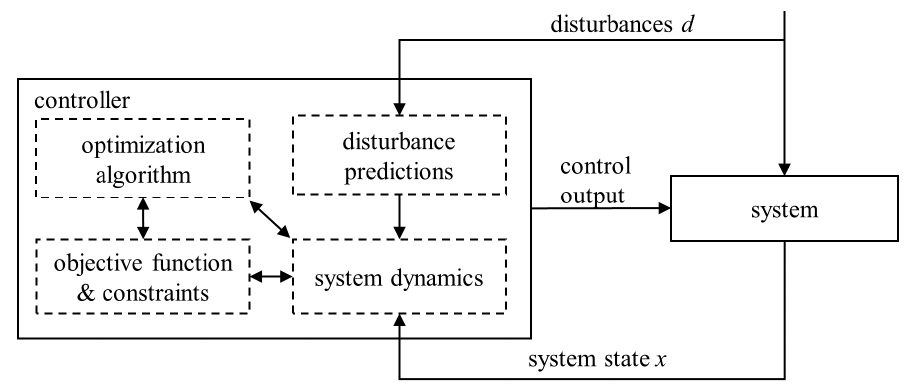
Figure 2. Model predictive control concept (adapted from Findeisen and Allgöwer [33]).